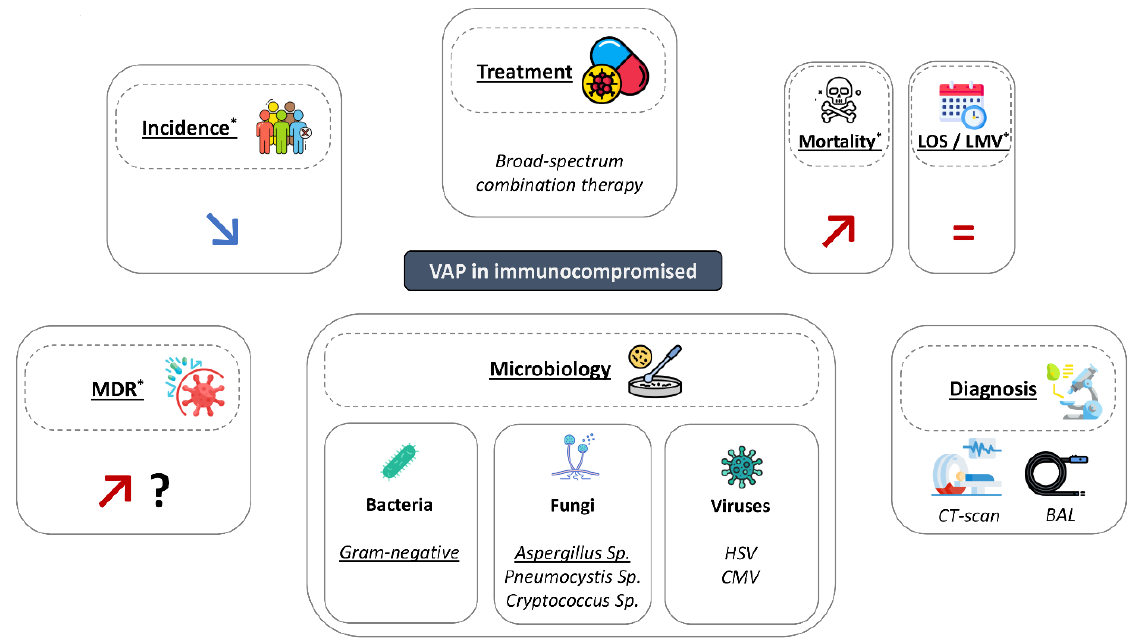
Figure 1. Main characteristics of ventilator-associated pneumonia in immunocompromised patients. BAL: broncho-alveolar lavage; LMV: length of mechanical ventilation; LOS: length of stay; MDR: multidrug resistant bacteria; VAP: ventilator-associated pneumonia. *: compared to immunocompetent patients.